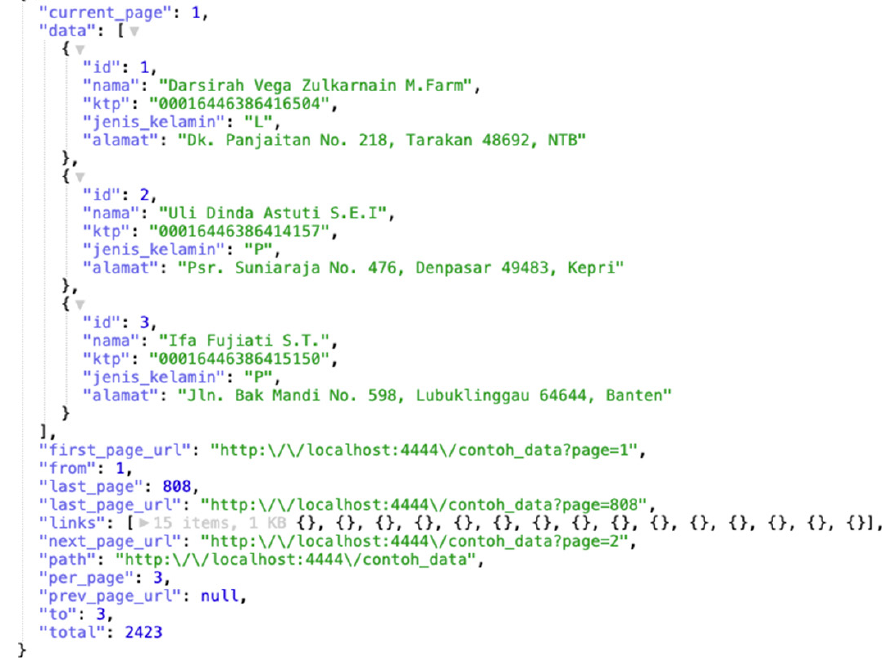
Fig 4. Example of the given